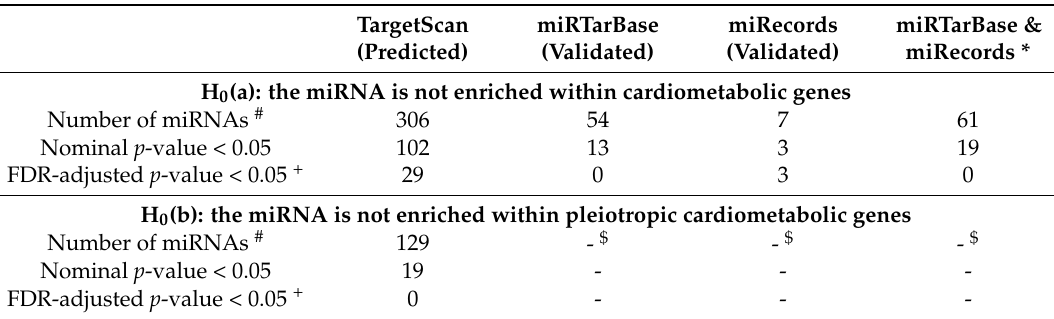
Table 2. Results of enrichment analysis.